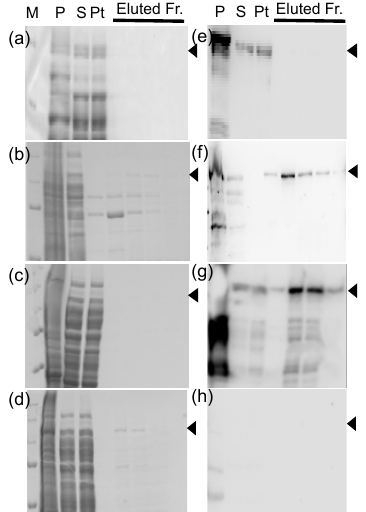
Figure 3. Analyses of four tagged Dicer-related helicase (DRH)-1 proteins purified using affinity-column chromatography. The 4.5 μ L aliquots of the stepwise eluted fractions from affinity column